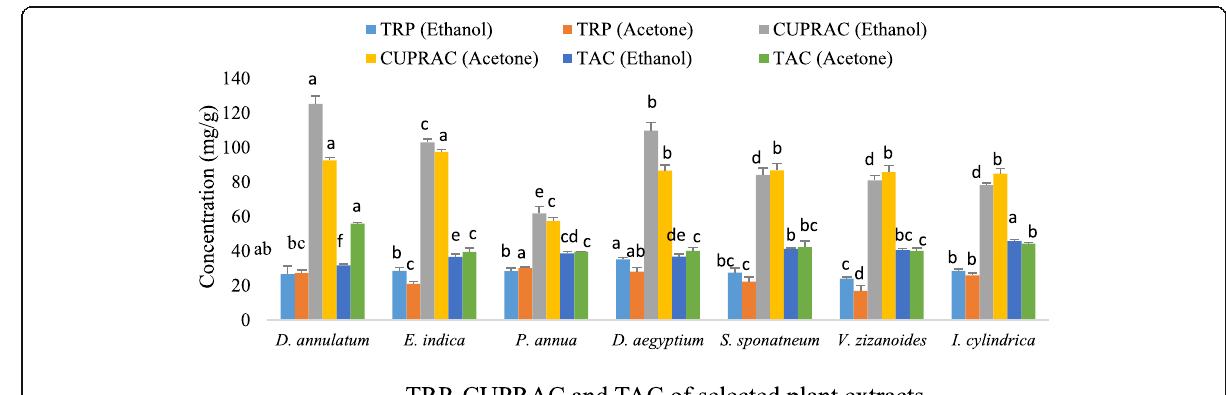
Fig. 2 TRP, CUPRAC and TAC of the selected plant extracts. Data represents the mean of three replicates and each letter (a-f) indicates significance at